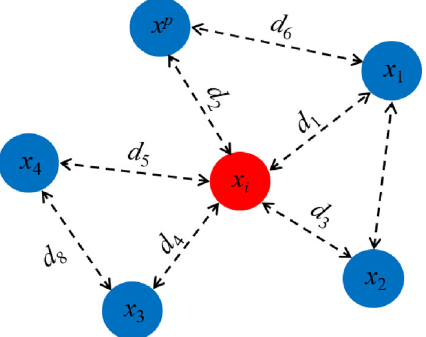
Fig.3 Theeightkindsofdistancebetweenparentsinvolvedinthemuta- tion. Manhattan distance is used to describe the positional relationship in the decision